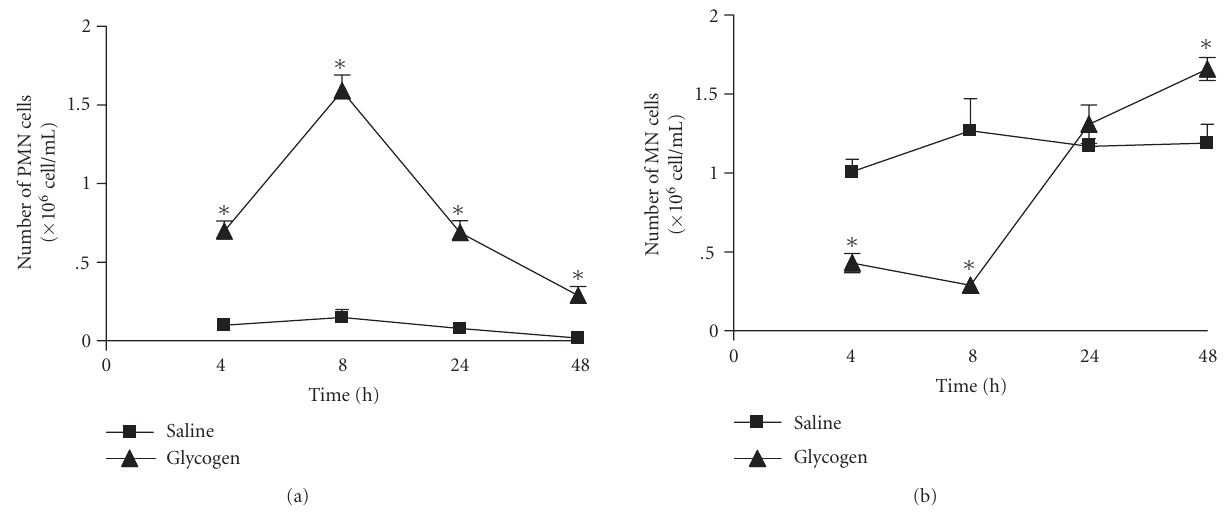
Figure 1: Kinetics of leukocyte influx to peritoneal cavity of mice after IP injection of a glycogen solution (5%, 500 μ L/animal). Number of polymorphonuclear cells (PMN cells; (a)) and mononuclear cells (MN cells; (b)). Results are expressed in absolute numbers obtained in SEM for 8–16 animals for each experimental time. (cid:0) P < . 05 relation to the total number of collected cells. Values represent mean values (cid:0) in comparison with values obtained in control animals.